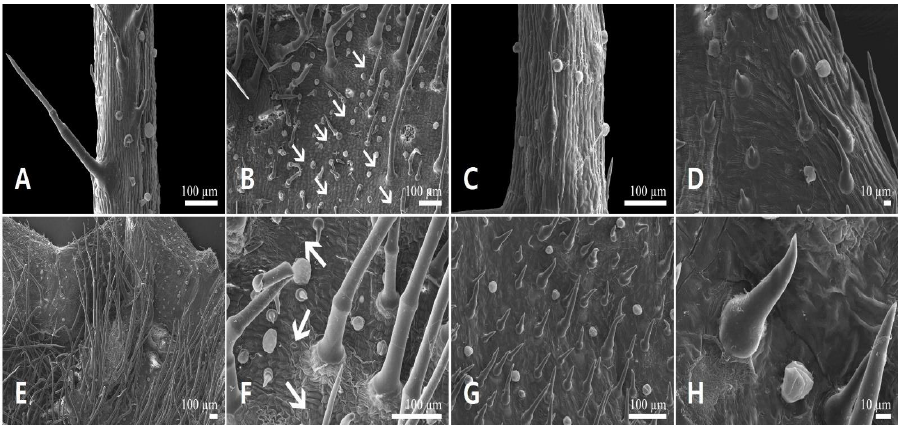
Figure 6. Scanning electron micrographs of the calyx epidermis in Leonurus macranthus . ( A , B ) Abaxial side of the calyx lobe. ( C , D ) Adaxial side of the calyx lobe. ( E , F ) Abaxial side of the calyx tube. ( G , H ) Adaxial side of the calyx tube. Arrows indicate floral stomata.